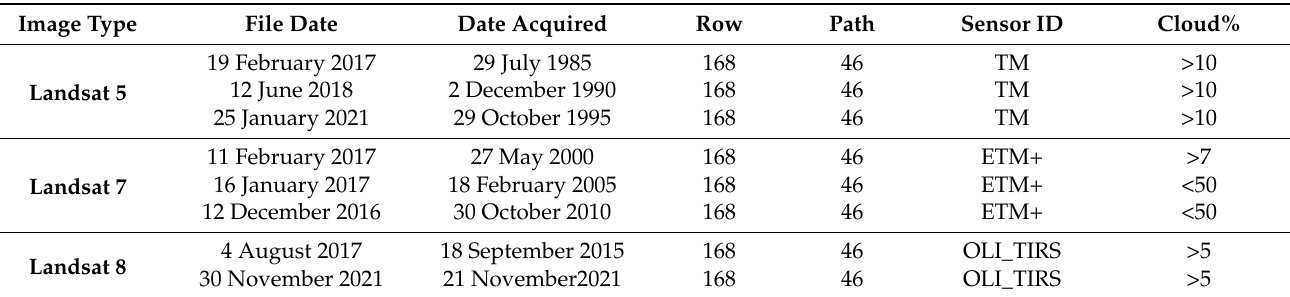
Table 1. Remote sensing databases